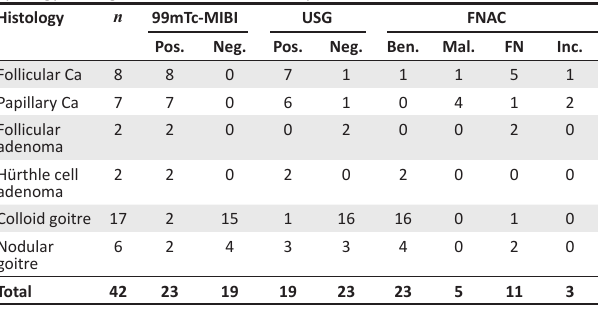
TABLE 1: Summary of 99mTc-MIBI, ultrasonography and fine needle aspiration cytology findings in the assessment of thyroid nodules.